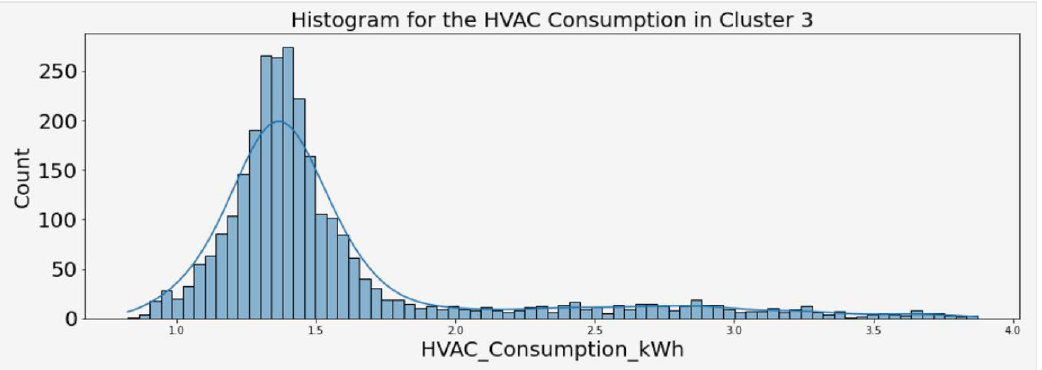
Figure 16. HVAC consumption in cluster3—second SOM.